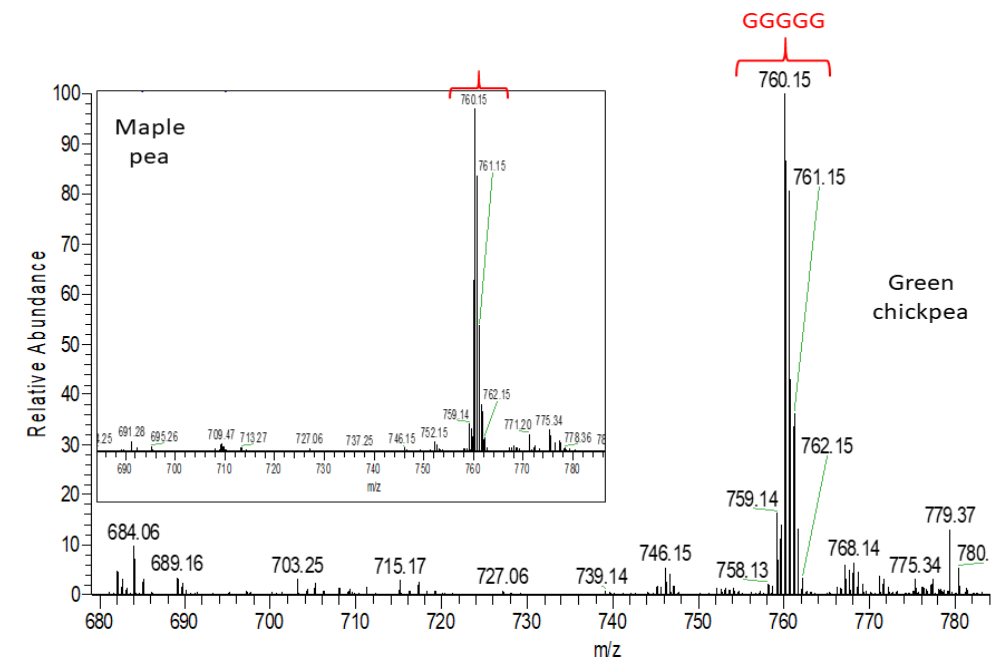
Figure 8. High resolution mass spectrometric (HRMS) full scan showing a prodelphinidin pentamer detected in chickpea and pea seed coats. Brackets with the same color have the same pentamer structure. G: (epi)gallocatechin.